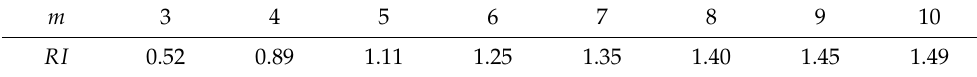
Table 3. Random consistency index.